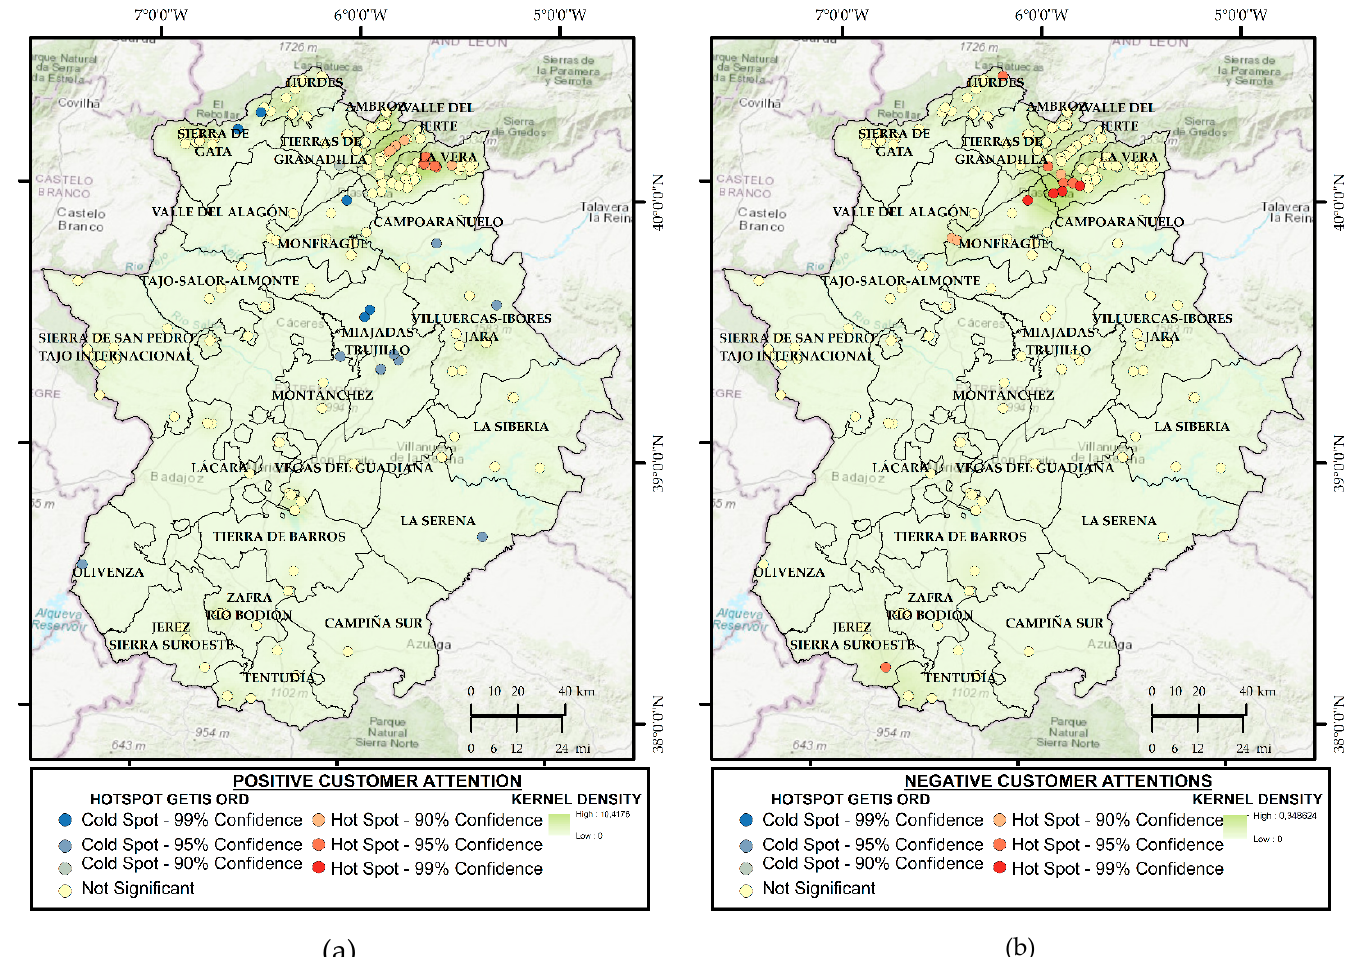
Figure 6. Gi* Getis Ord on Customer Attention Positive ( a ) and Negative ( b )